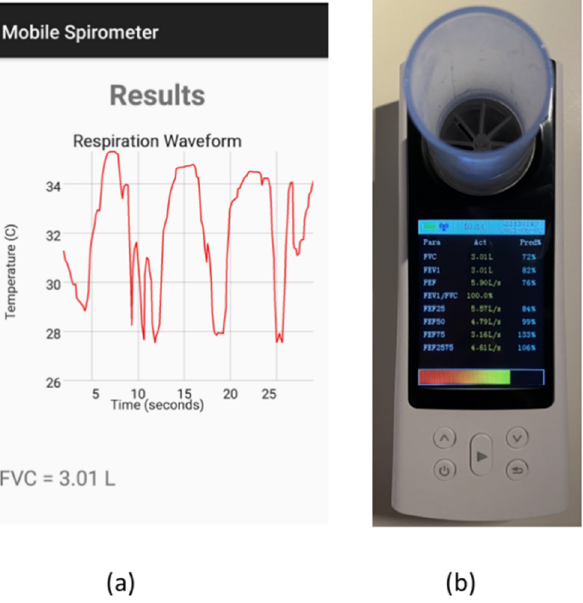
Figure 12. FVC test measurement: ( a ) mobile app reading; ( b ) conventional spirometer reading.